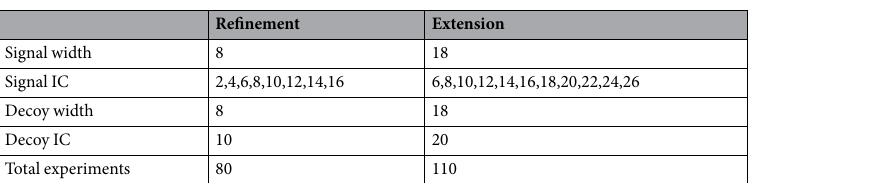
Table 3. The average performance of each method on 134 ChIP-seq datasets. For each tool, its average performance on both training and test datasets are presented.